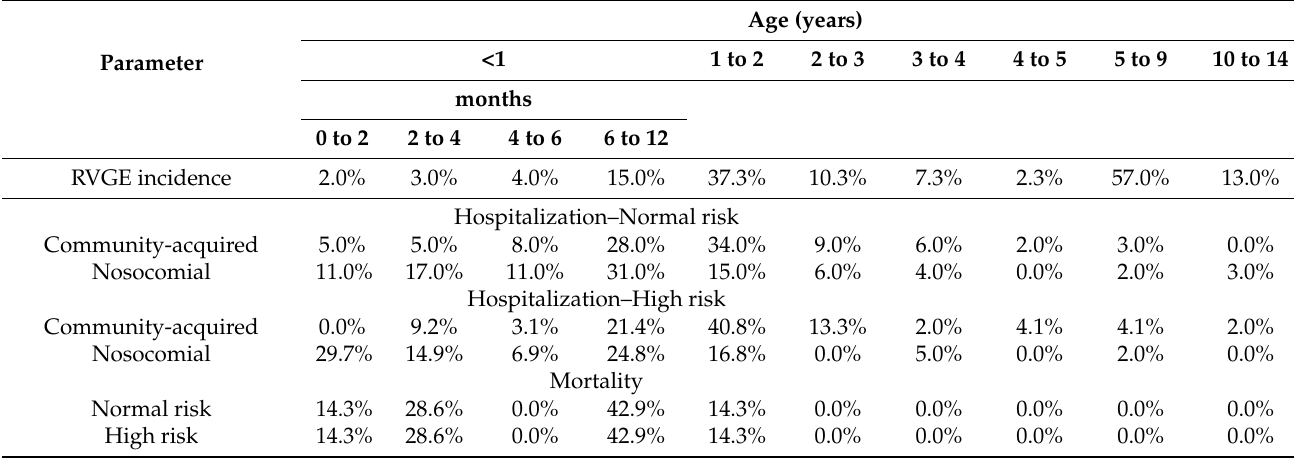
Table 2. Age distribution of rotavirus incidence, hospitalizations, and mortality for low and high-risk infants (source Bruijning-Verhagen et al.